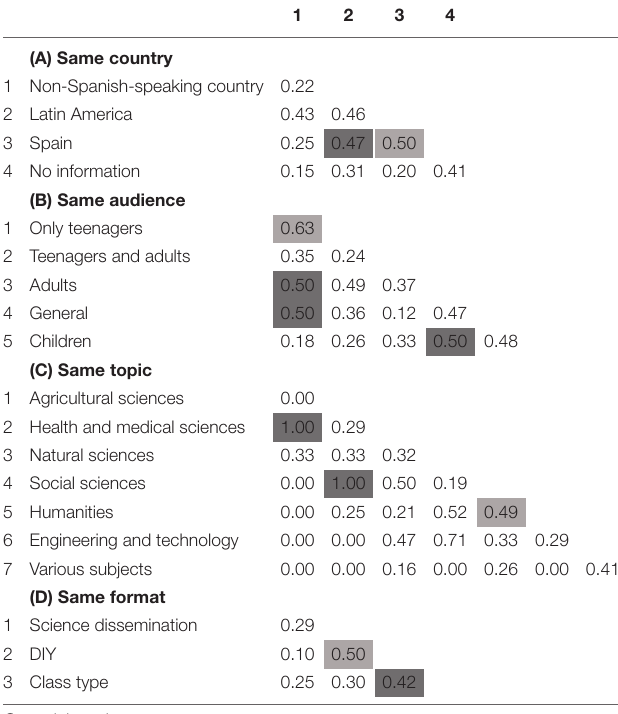
TABLE 7 | Reciprocity analysis by groups of channels that share similar